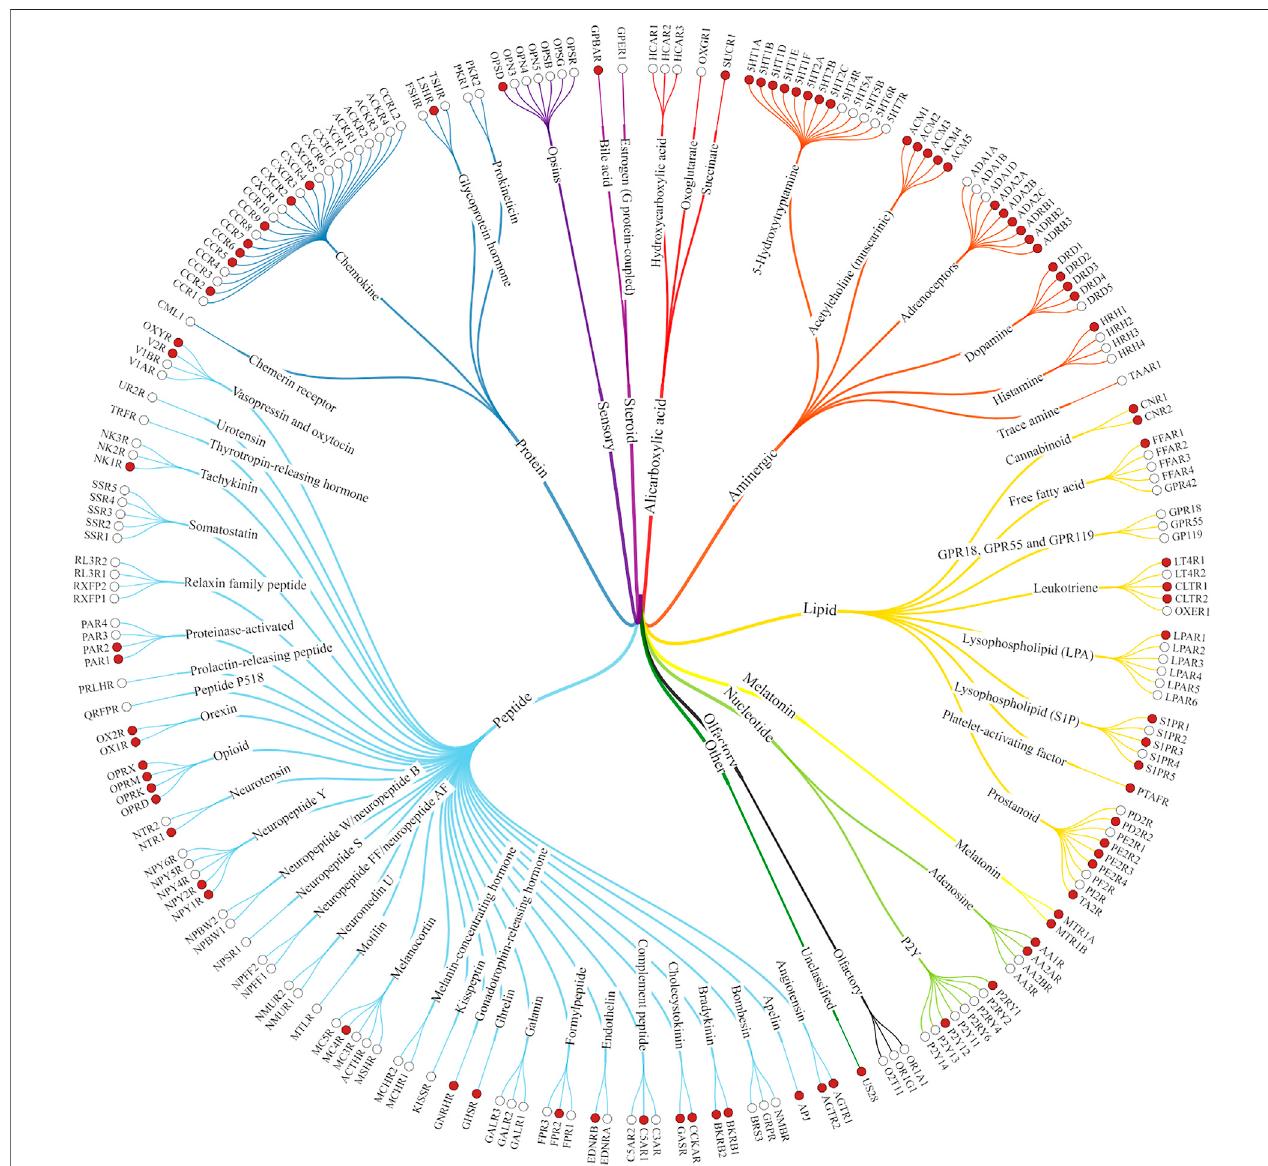
FIGURE 1 | Class A GPCRs. The structures of the receptors marked with red dots have already been solved experimentally (Kooistra et al., 2021).